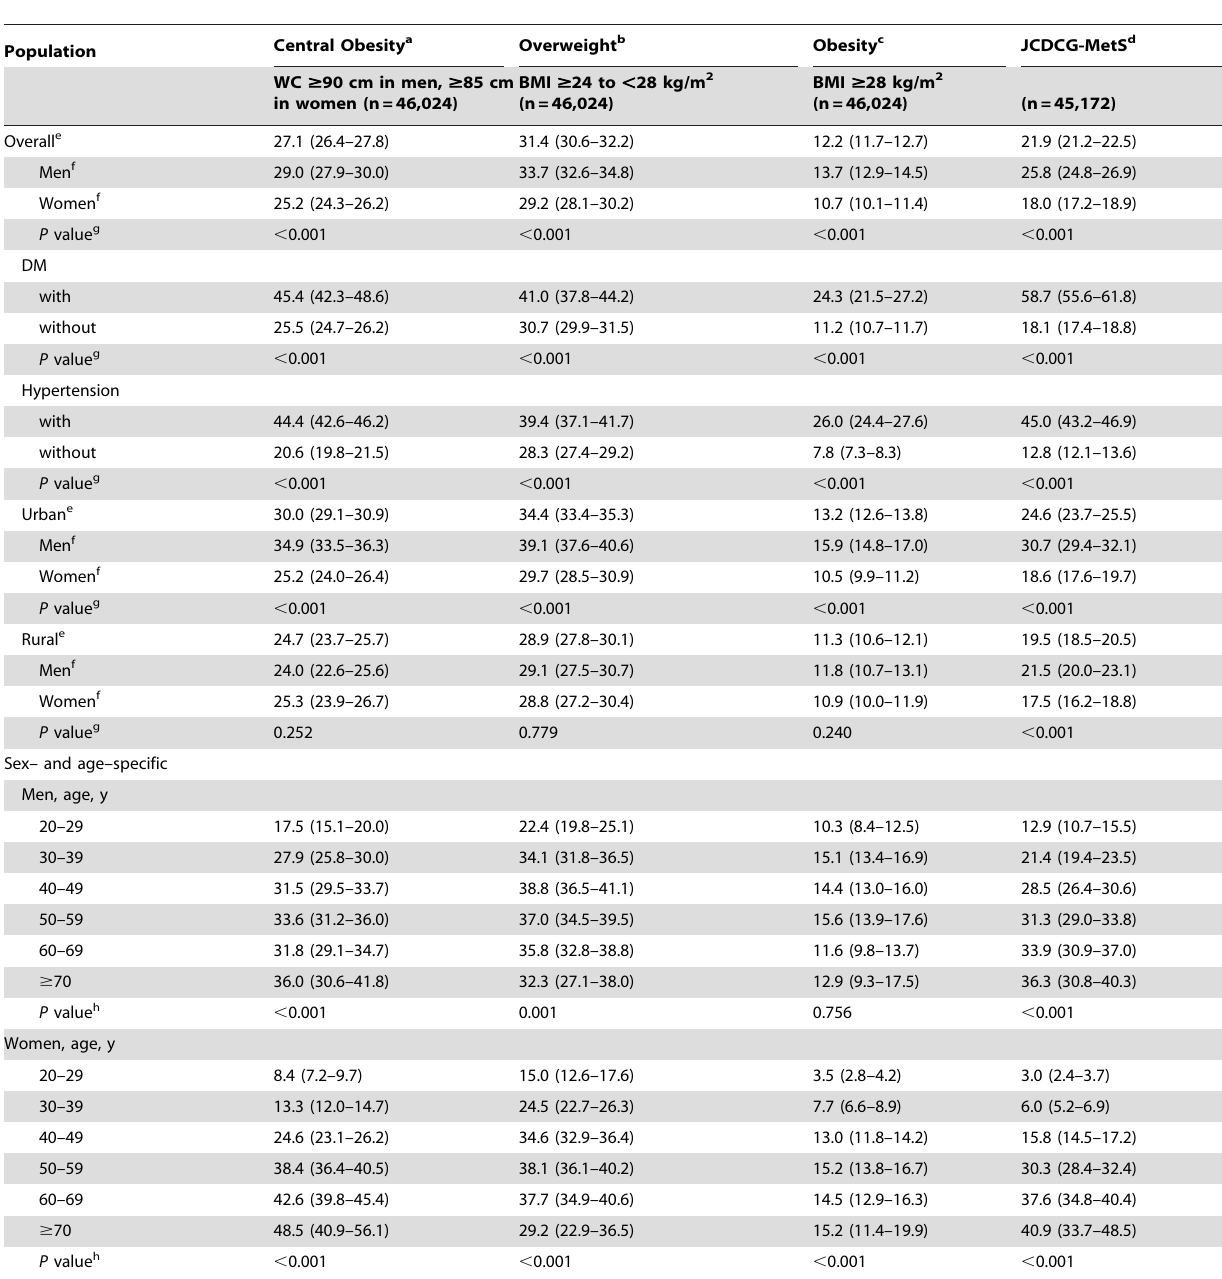
Table 2. Standardized Proportion (95% Confidence Interval) of Central Obesity, Overweight, and Obesity in Chinese Adults $ 20 Years,